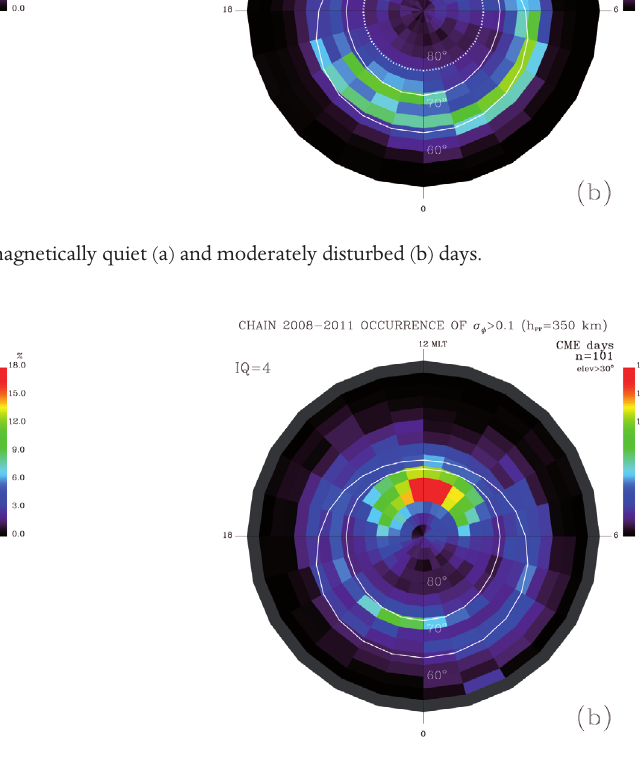
Figure 3. Phase scintillation occurrence maps for days of CIRs/HSSs (a) and ICMEs